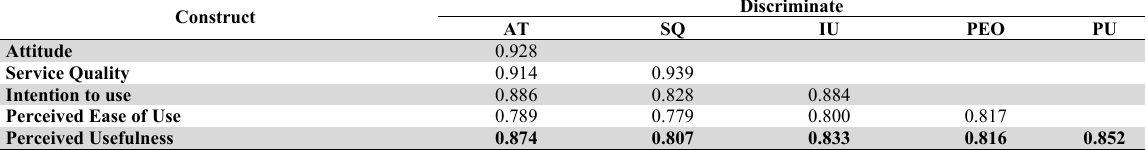
Discriminate validity of Small broadband ISPs